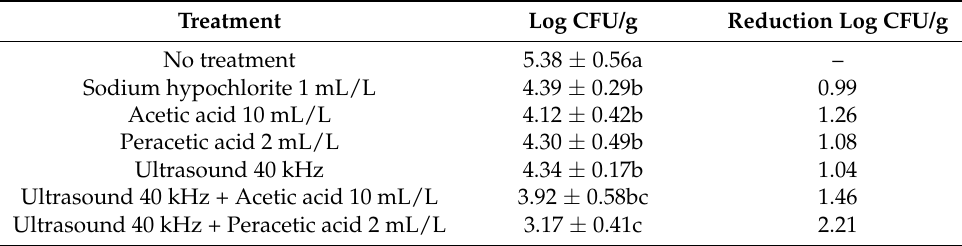
Table 5. Escherichia coli ATCC 11229 count in log CFU/g adhered to strawberry’s surface (no treat- ment) and after being submitted to different procedures of